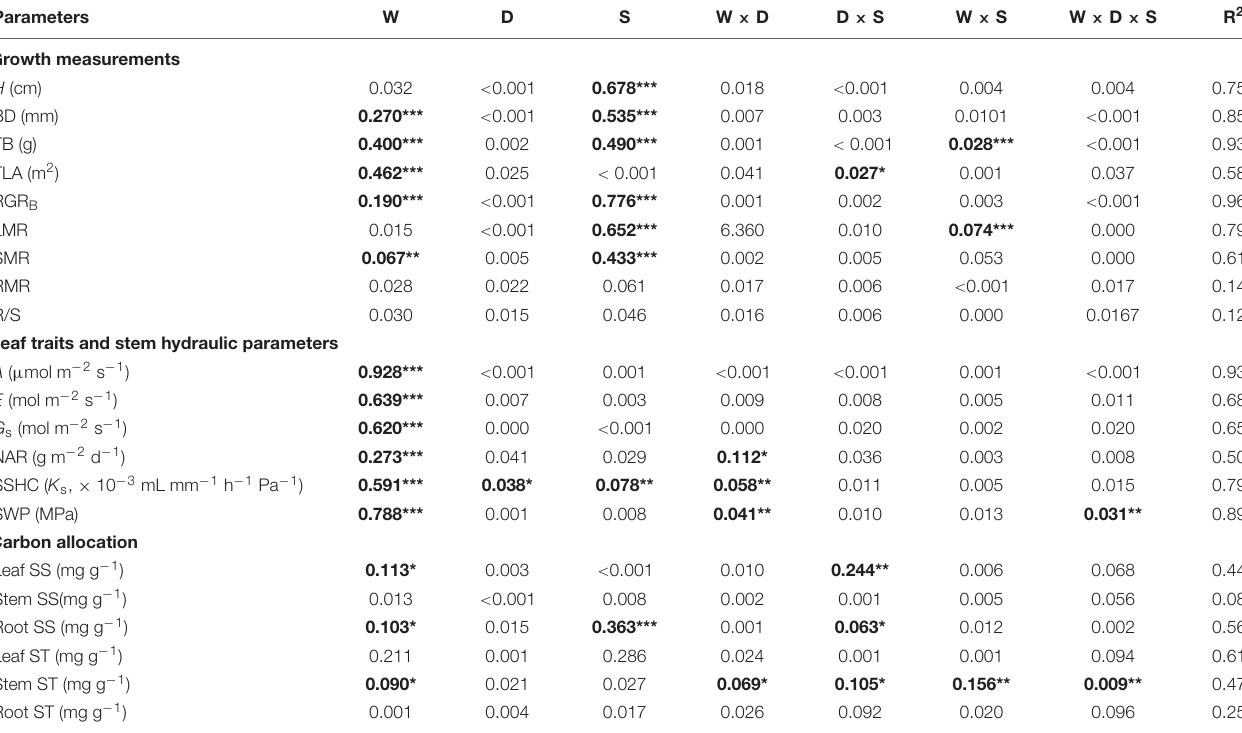
TABLE 1 | The proportion of explained variation from water availability (high water availability vs. low water availability), defoliation (defoliation vs. non-defoliation), plant size (small vs. large) and their interactions on 21 measured traits for R. pseudoacacia seedlings.